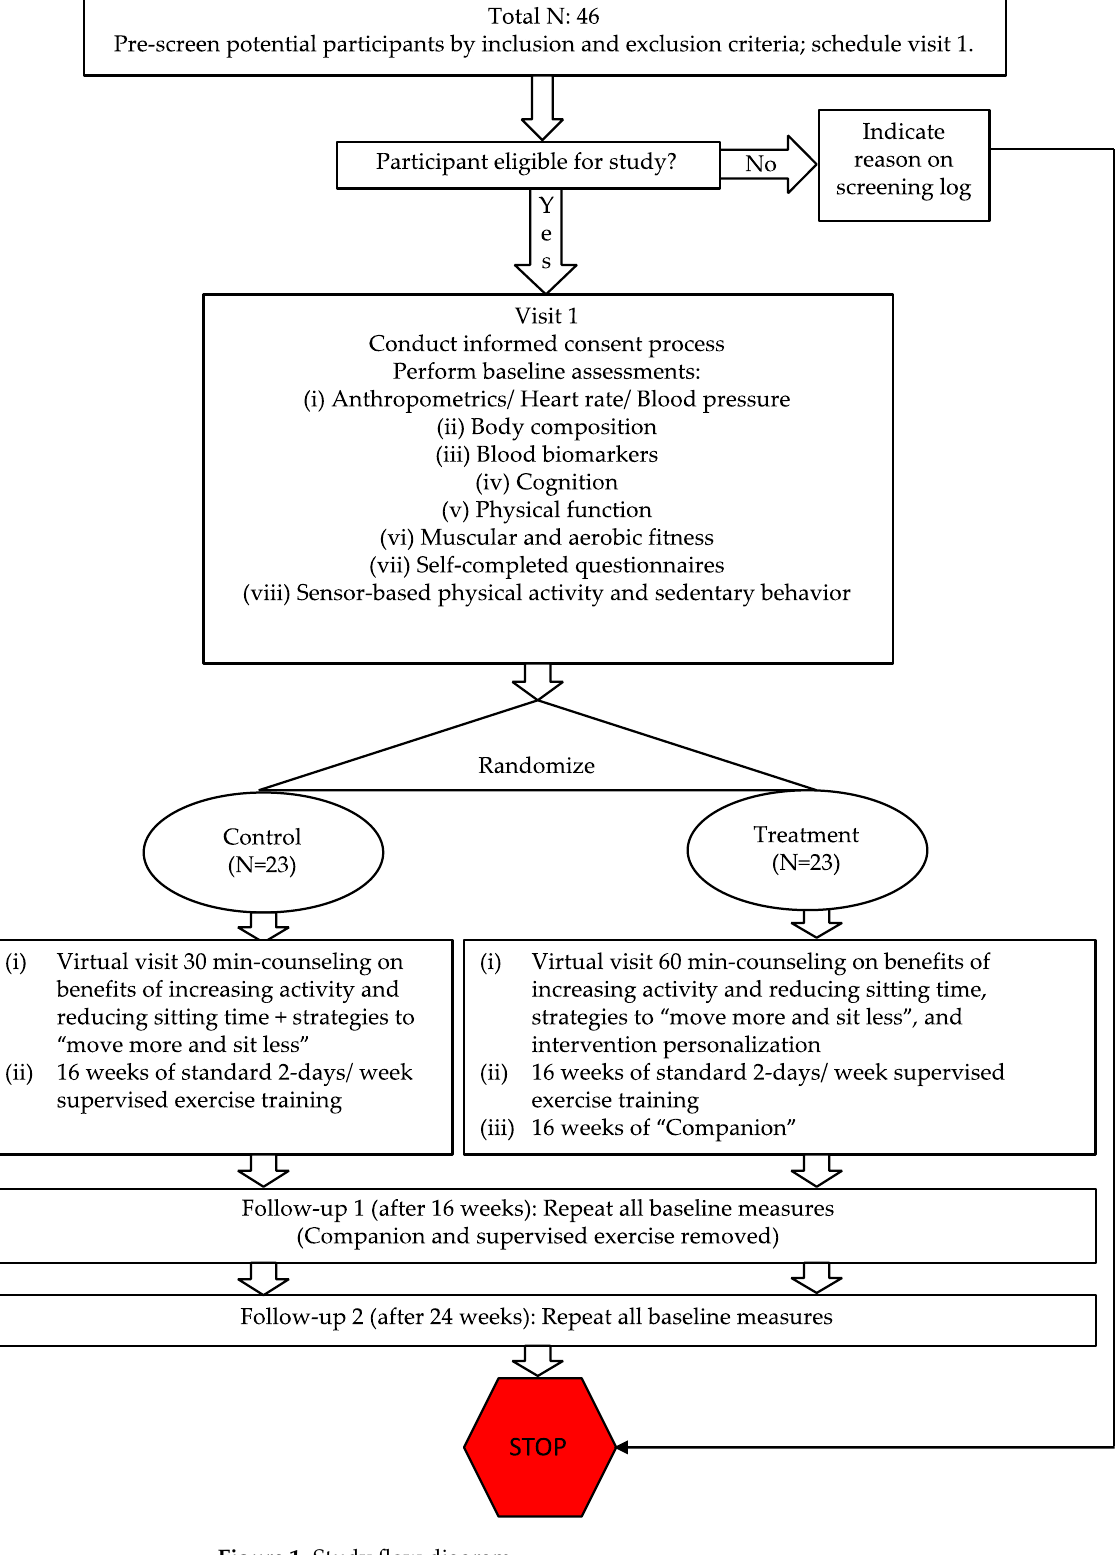
Figure 1. Study flow diagram.